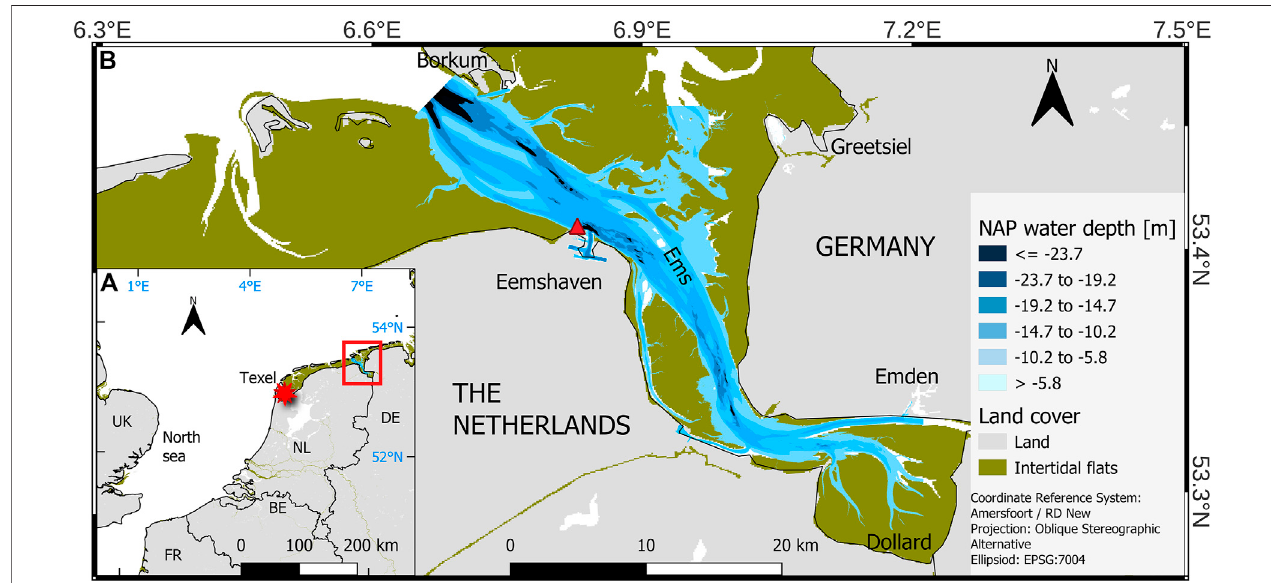
FIGURE 1 | The study area: (A) locations of the Ems Dollard Estuary (red box) and the Texel station (red star); (B) bathymetry of the Ems Dollard Estuary, water qualitydataareobtainedfromtheEemshavenstation(redtriangle).CoastlinesarefromEEA(2018),Bathymetry dataarefromPierik(2019),landclassesarefromCorine